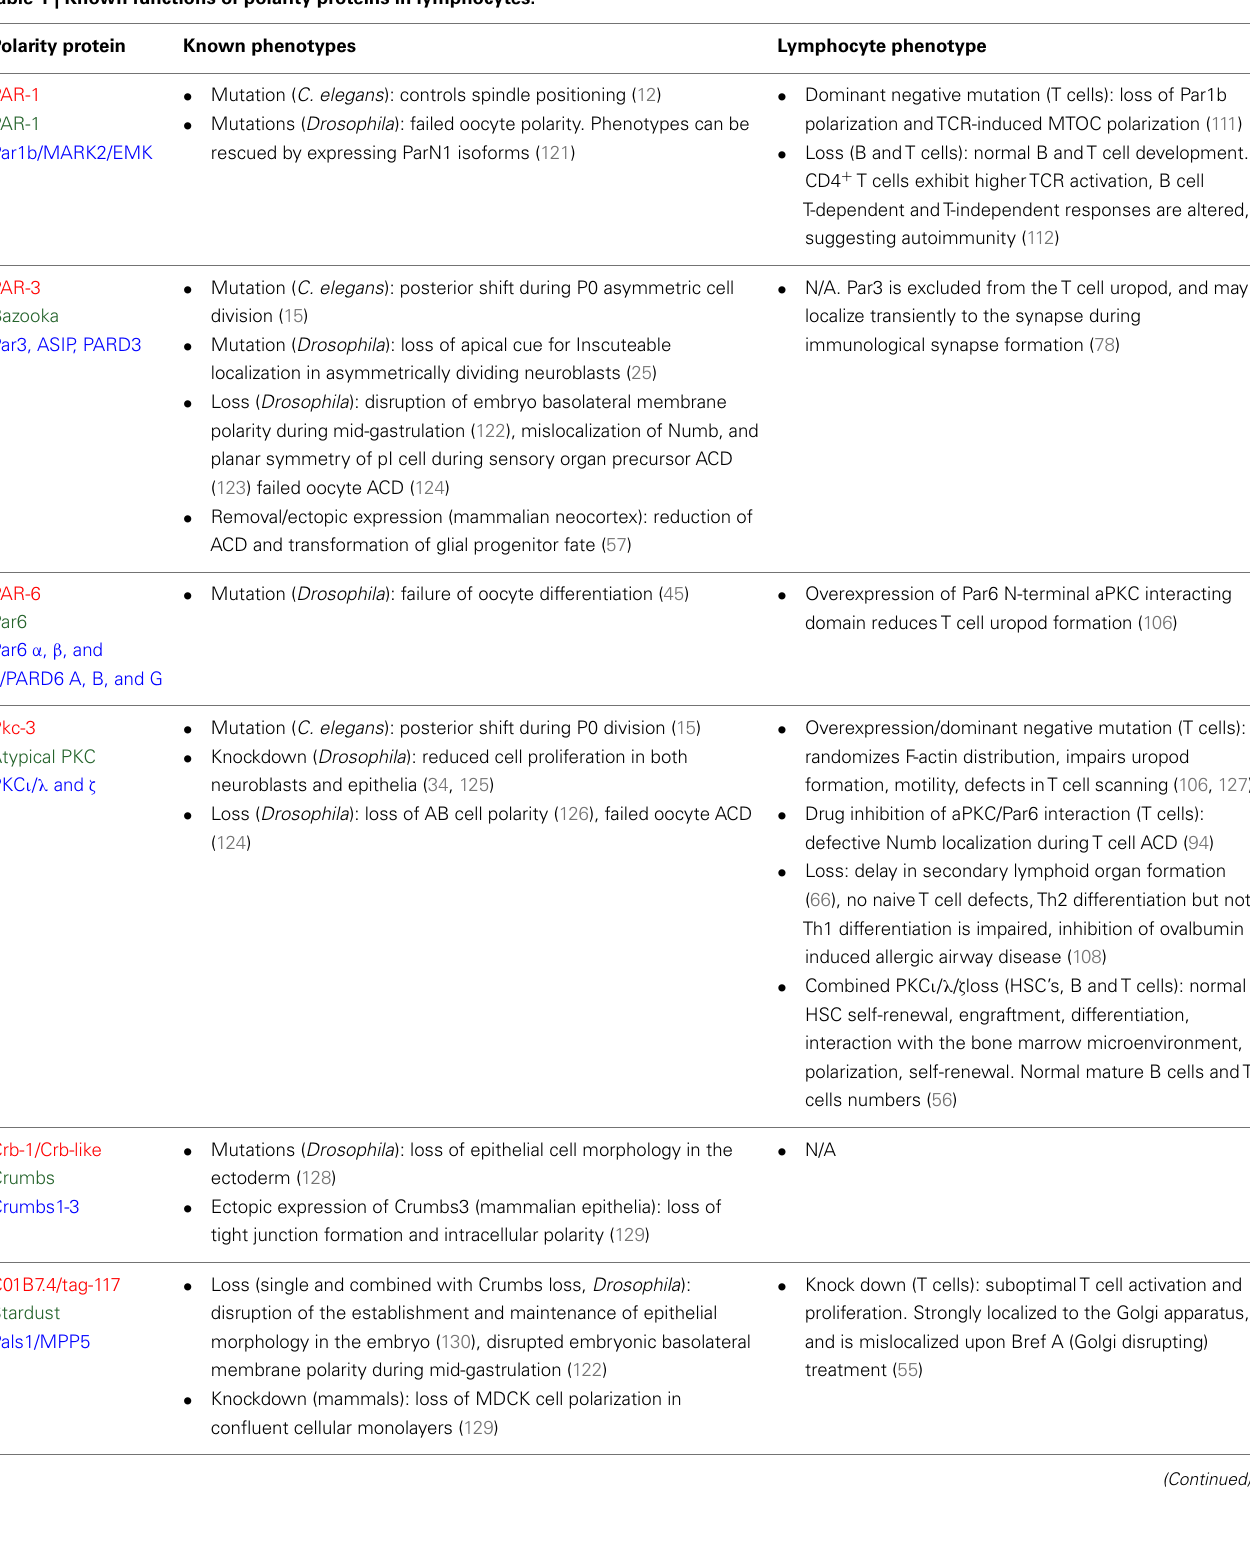
Table 1 | Known functions of polarity proteins in